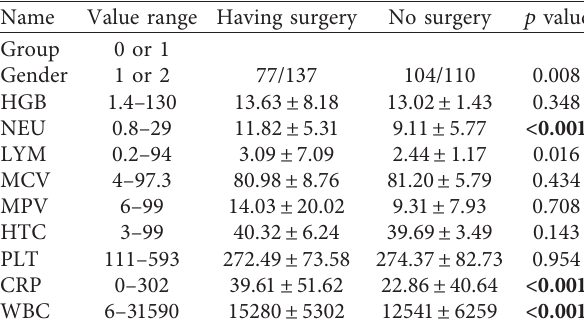
Table 2: Blood test results in acute appendicitis dataset.